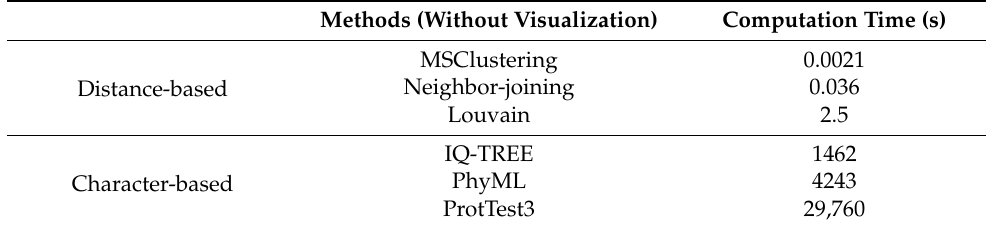
Table 1. Computation time of analyzing 197 GPCRs with distance-based or character-based